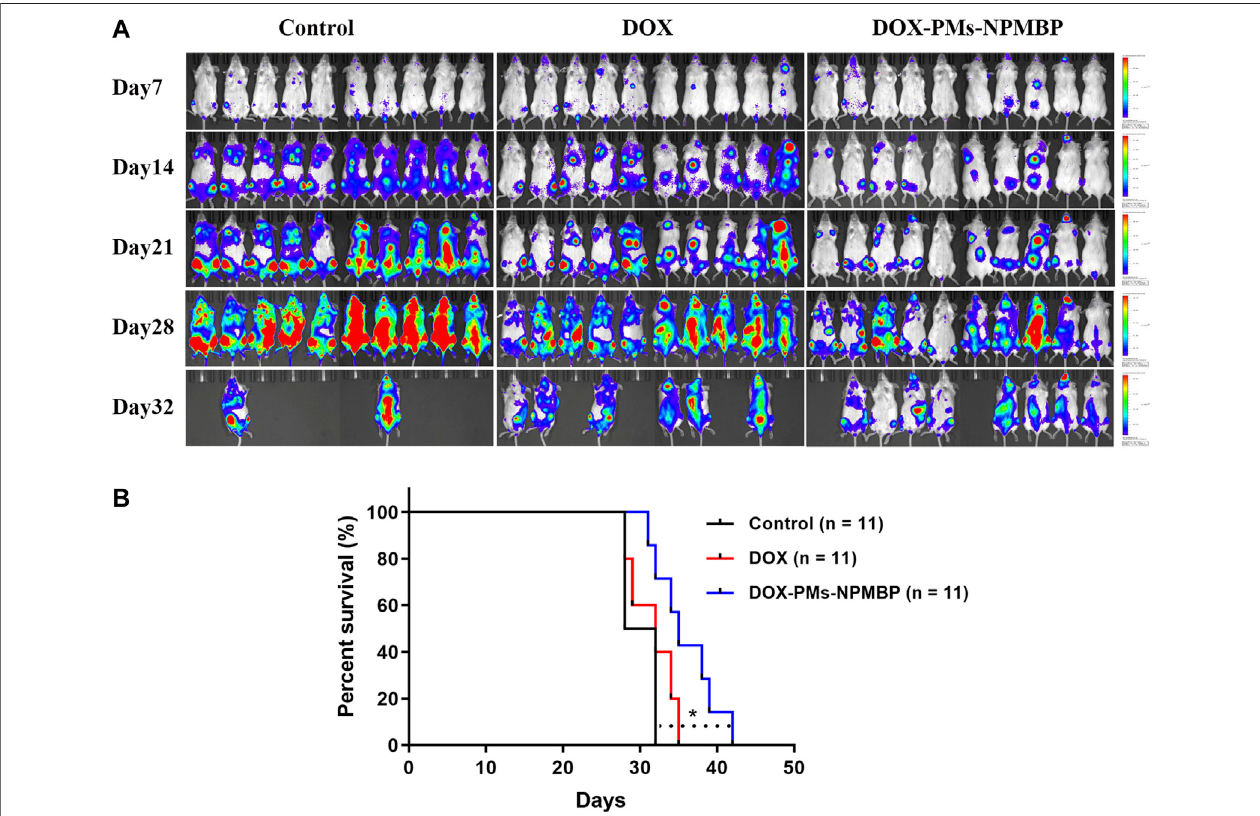
FIGURE 8 | DOX-PMs-NPMBP improves survival in NCG mice implanted with Nalm6-Luc/DOX cells. The day of implantation with Nalm6-Luc/DOX cells was designated as day 0. ALL xenograft models were monitored during the study period. Survival time of the recipients were recorded. (A) Representative bioluminescence images of the ventral/dorsal area taken on different time points during follow-up. (B) Kaplan-Meier survival curves. * p < 0.05 compared with control.